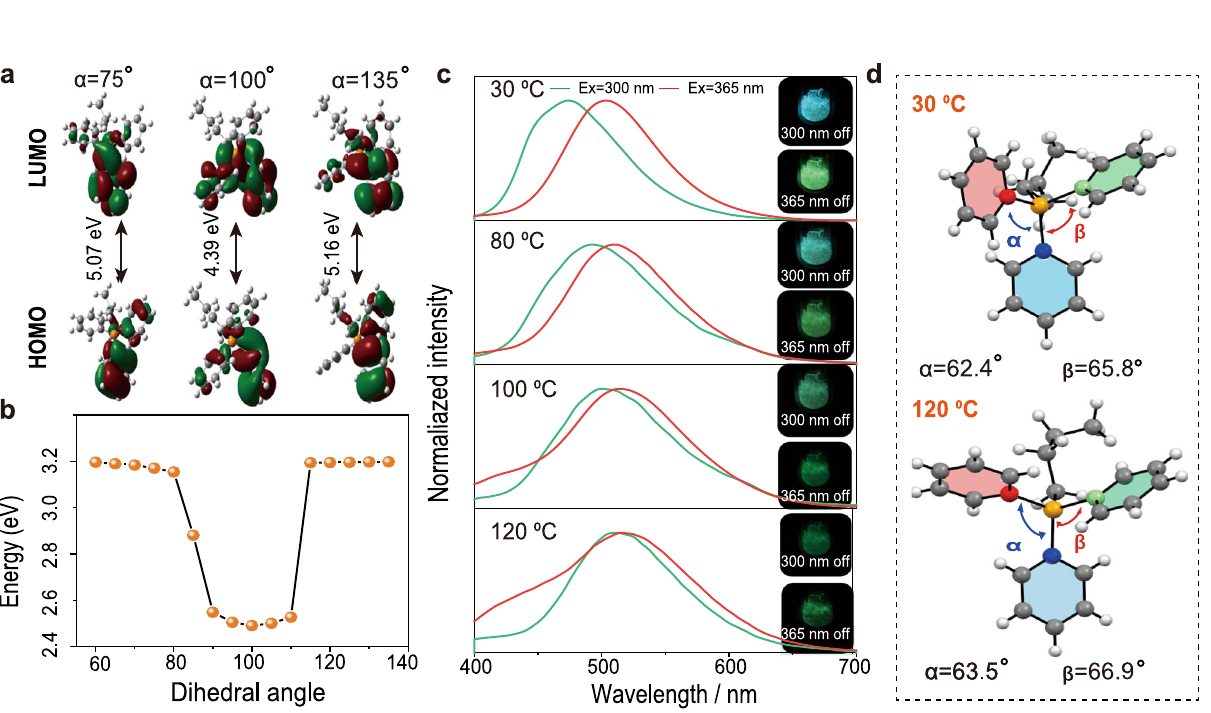
Fig.3|TheoreticalcalculationandthermalresponsiveRTPbehavior.a Frontier molecular orbitals and excitation energies of the lowest excited triplet states of different C1 form molecules atTDAB3LYP/def2-SVP leveloftheory. b Relationship between the levels of the lowest-lying triplet states energy and changed dihedral